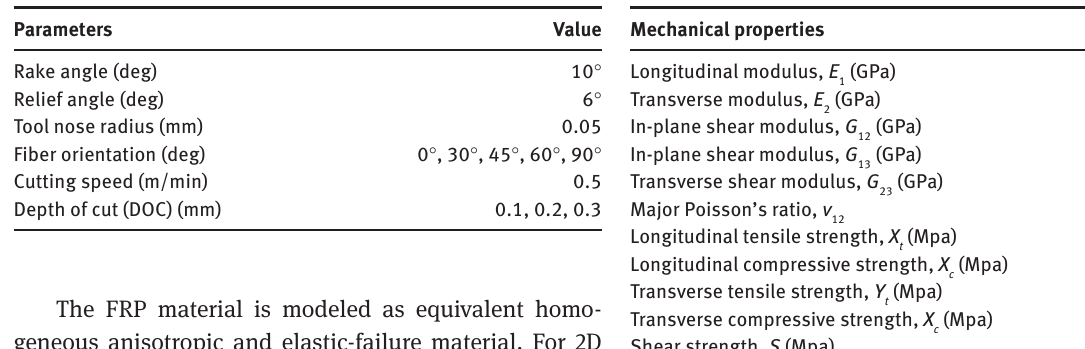
Table 2: Material properties [5,